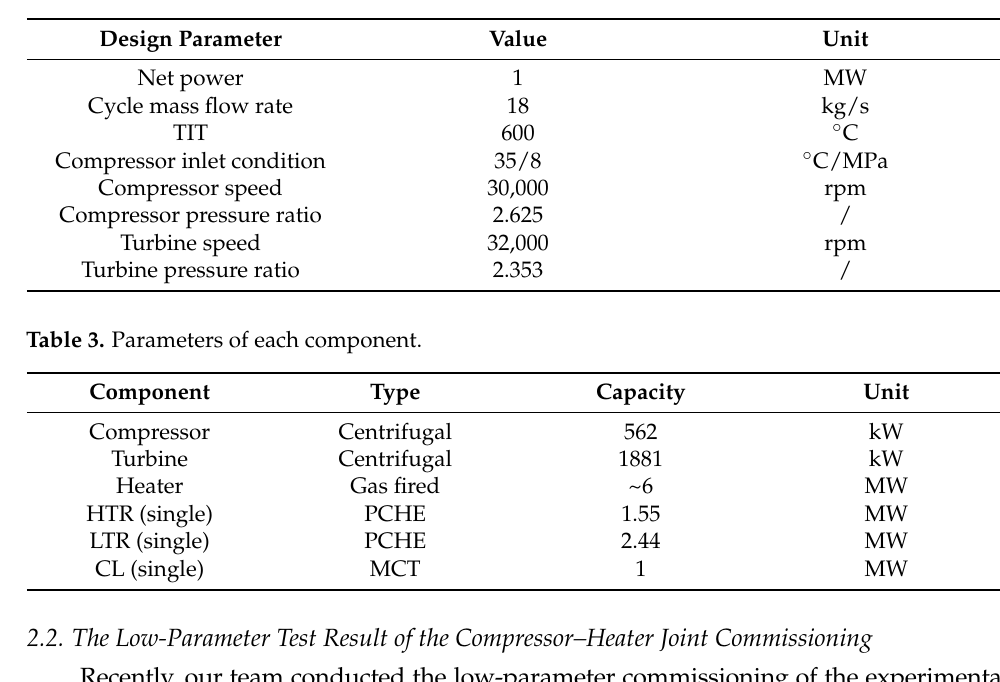
Figure 1. System layout: ( a ) photo of the experimental system; ( b ) configuration. Table 2. Nominal parameters of the experimental system.